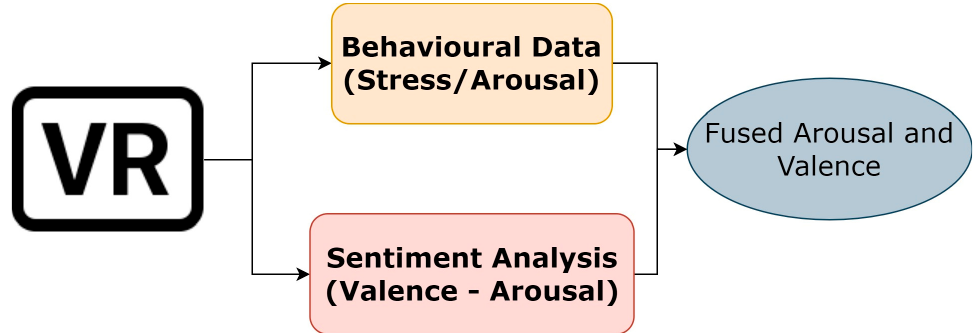
Figure 2. Image sentiment analysis and behavioural analysis fusion.